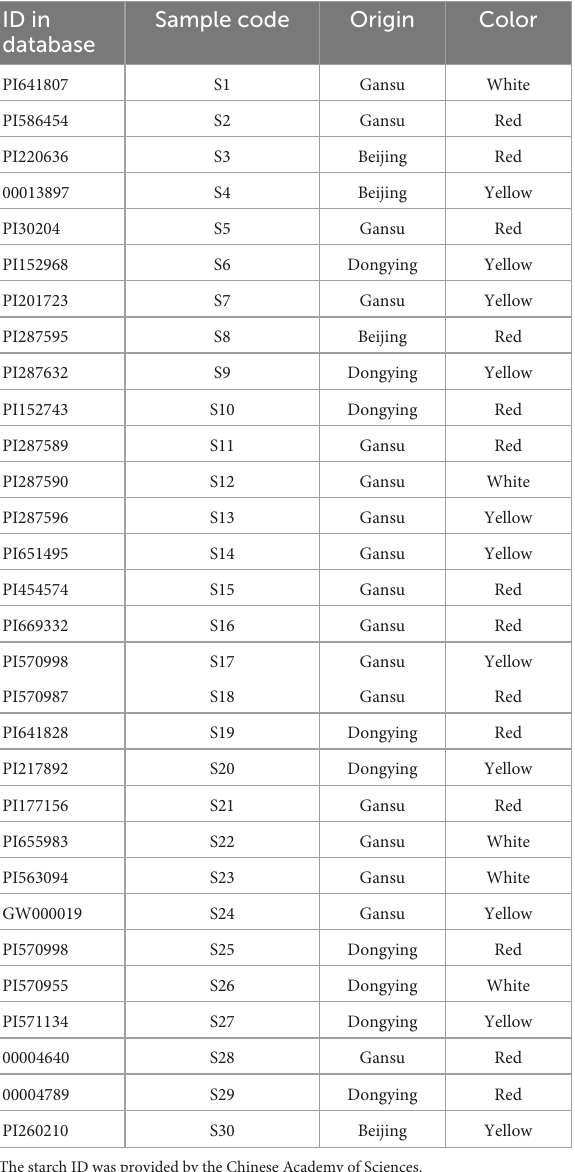
TABLE 1 Product information of sorghum